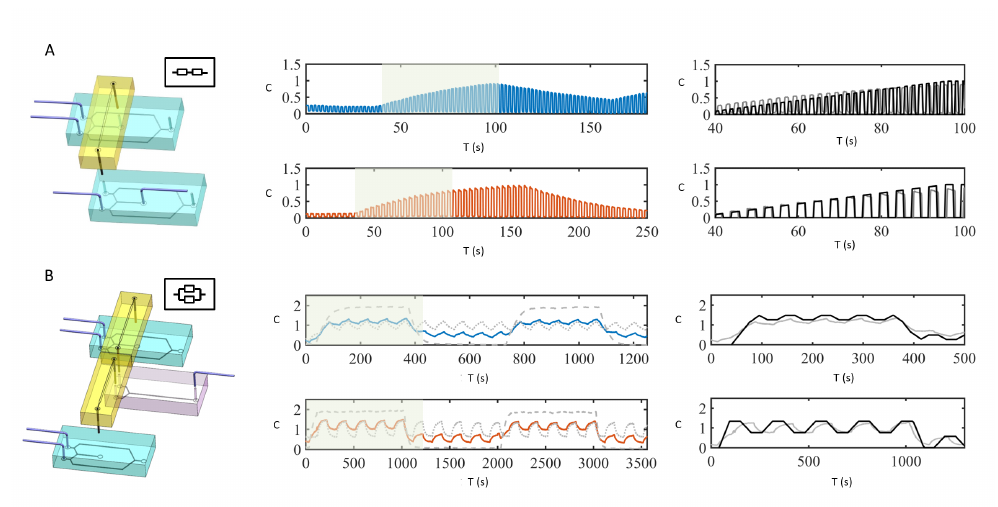
Figure 4. Two basic connection patterns. ( A ) ( Left ) Serial connection: it consists of two oscillators and one integrator, such that the first oscillator provides a slowly varying signal and the second one samples between the input signal and a referencing point (e.g., C = 0); ( Center ) The solid lines represent experimentally measured concentration profiles for two different oscillator settings; ( Right ) Comparison between experimentally measured signal (solid gray line) and the analytic prediction in Equation (4) (solid black line) in the shaded time-window. The analytical solutions are calculated with T C 1 = T C 2 = 55 s for the input function and T C 1 = T C 2 = 0.5 s for the sampling ( top panel ) and T C 1 = T C 2 = 55 s for the input function and T C 1 = T C 2 = 1.6 s for the sampling ( bottom panel ). ( B ) ( Left ) Parallel connection: it contains two integrators and three oscillators, where the two oscillators (top and bottom in the figure) connect directly to the injections and can produce different signals, while the one in the middle is used as a Y-connector and is the measuring point of the outcome concentration. ( Center ) The solid lines represent experimentally measured concentration profiles for two different oscillator settings; ( Right ) Comparison between the experimental signal (solid gray line) and the analytical expression Equation (5) (solid black line) in the shaded time-window. The analytical solutions are calculated with input signals T C 1 = T C 2 = 35 s and T C 1 = T C 2 = 320 s ( top panel ) and T C 1 = T C 2 = 110 s and T C 1 = T C 2 = 1000 s ( bottom panel